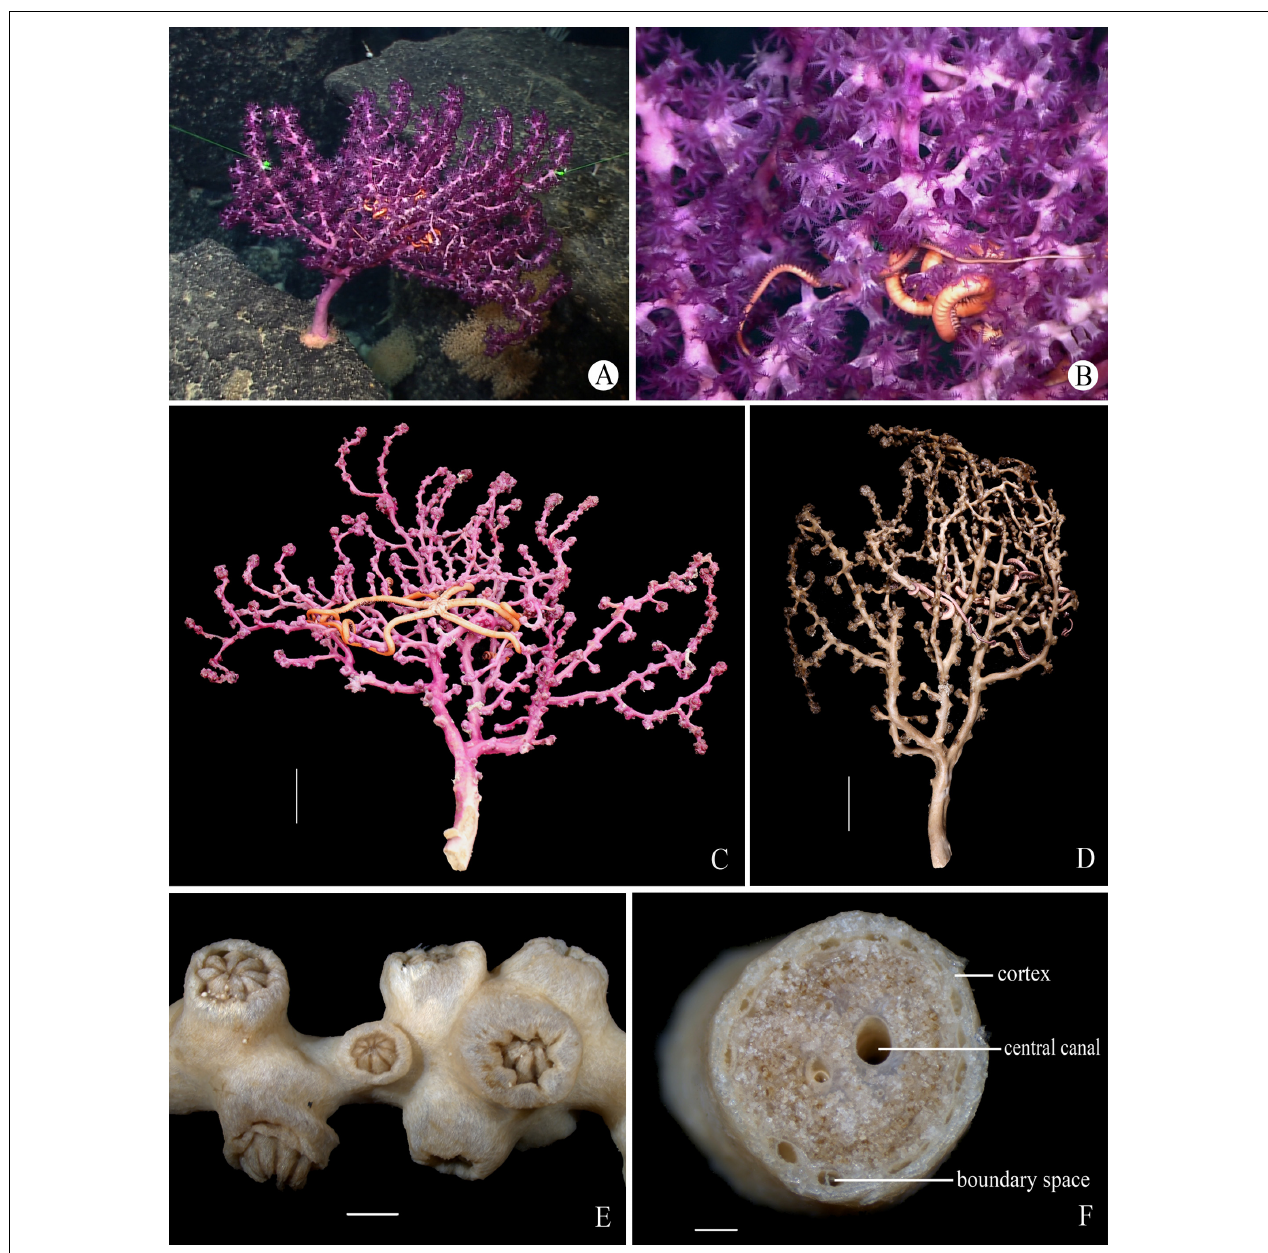
FIGURE 9 | The specimen MBM286394 of Victorgorgia eminens Moore et al., 2017. (A) In situ . Laser dots spaced at 33 cm used for measuring dimensions. (B) Close view in situ , showing expanded polyps. (C) The freshly collected specimen, photographed by Shaoqing Wang. (D) The preserved specimen. (E) Retracted autozooids. (F) Cross-section of terminal medulla. Scale bars = 5 cm (C,D) , 2 mm (E) , and 0.5 mm (F) .